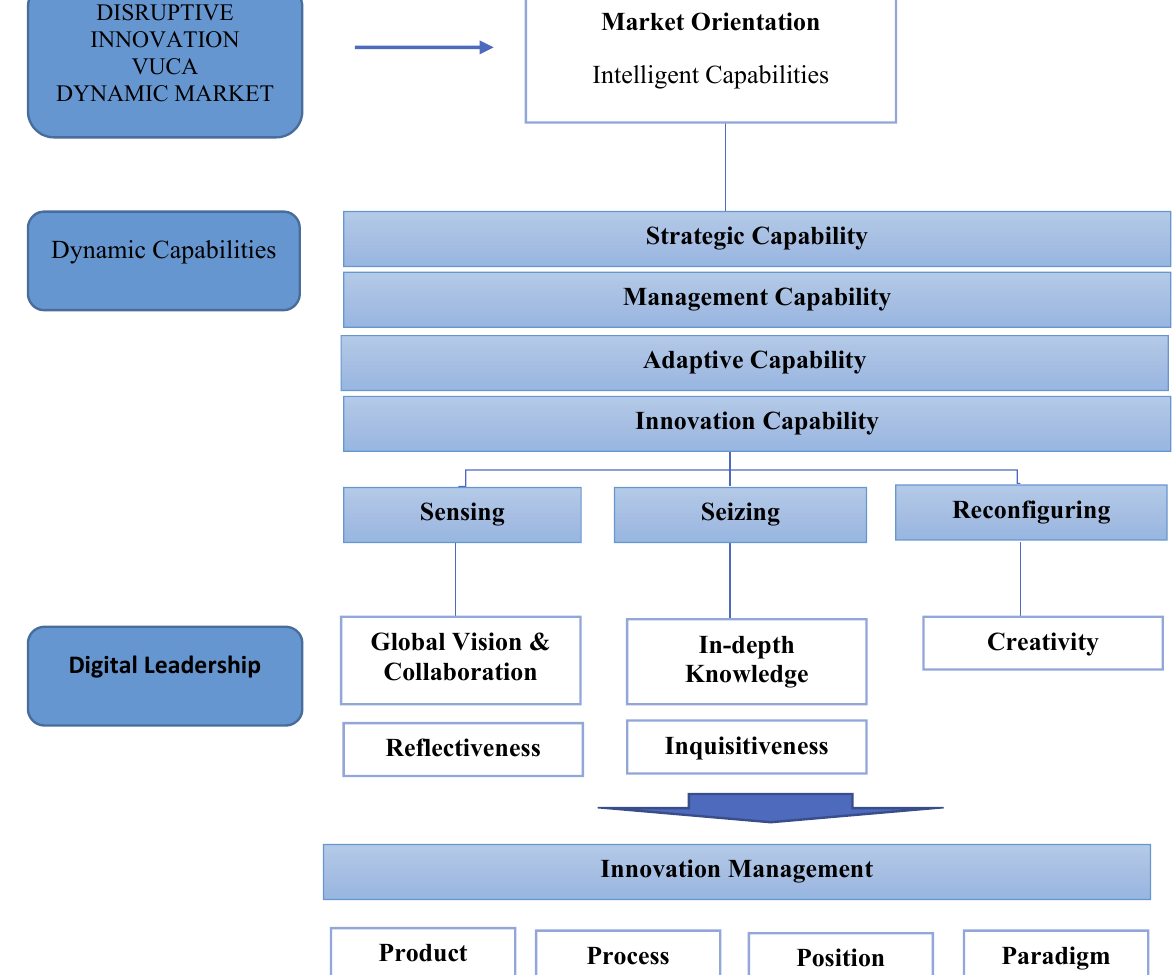
Fig. 3. Innovation-Based Dynamic Capability Framework (Schoemaker,